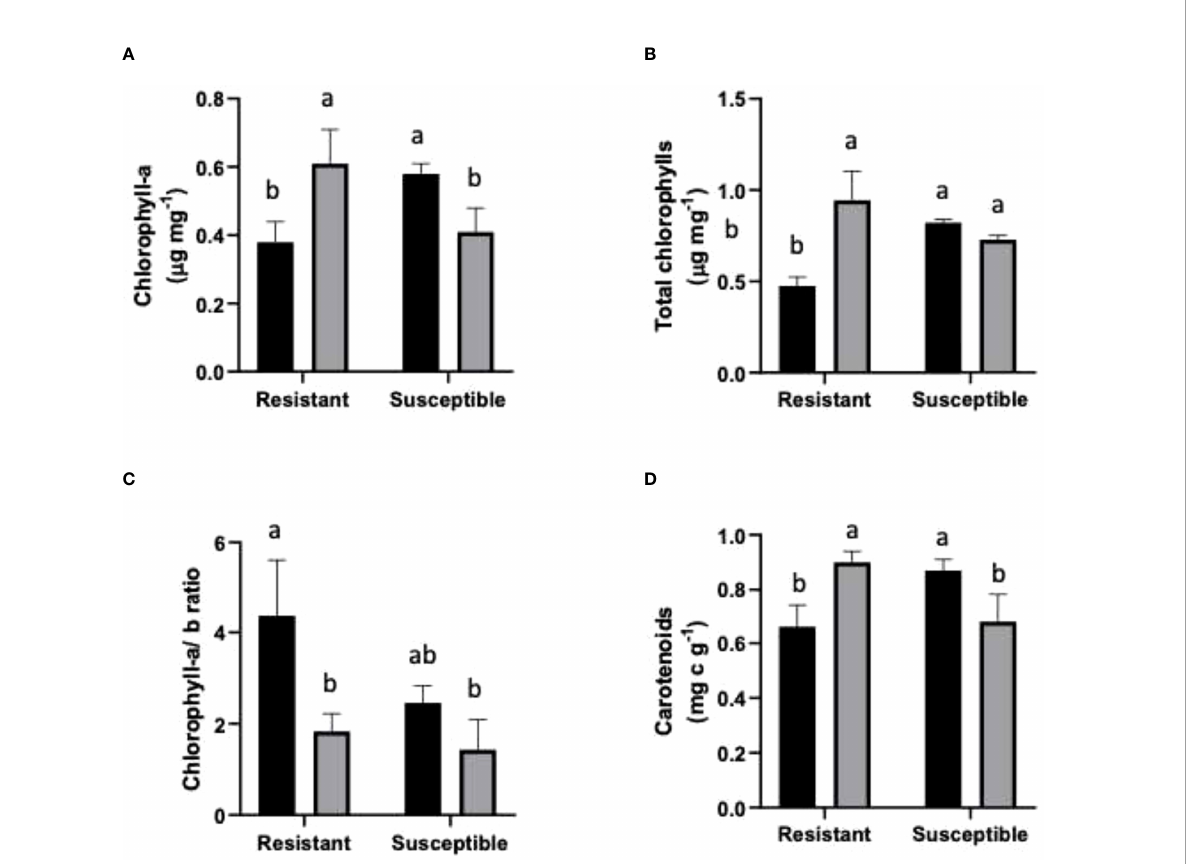
FIGURE 2 Photosynthetic pigments in resistant and susceptible plants. (A) Chl- a m g mg -1 FW; (B) Chl- a+b µg mg -1 FW; (C) Chl- a/b ratio; and (D) Carotenoids (mg g -1 FW). Black bars represent non inoculated plants, and grey bars indicate E. necator inoculated plants. Lowercase letters indicate statistically signi fi cant differences among inoculated and non-inoculated in factors interaction (genotypes*infection condition). Two-way ANOVA test and the Tukey multiple comparisons post-hoc test ( p ≤ 0.05) (n=3 ±